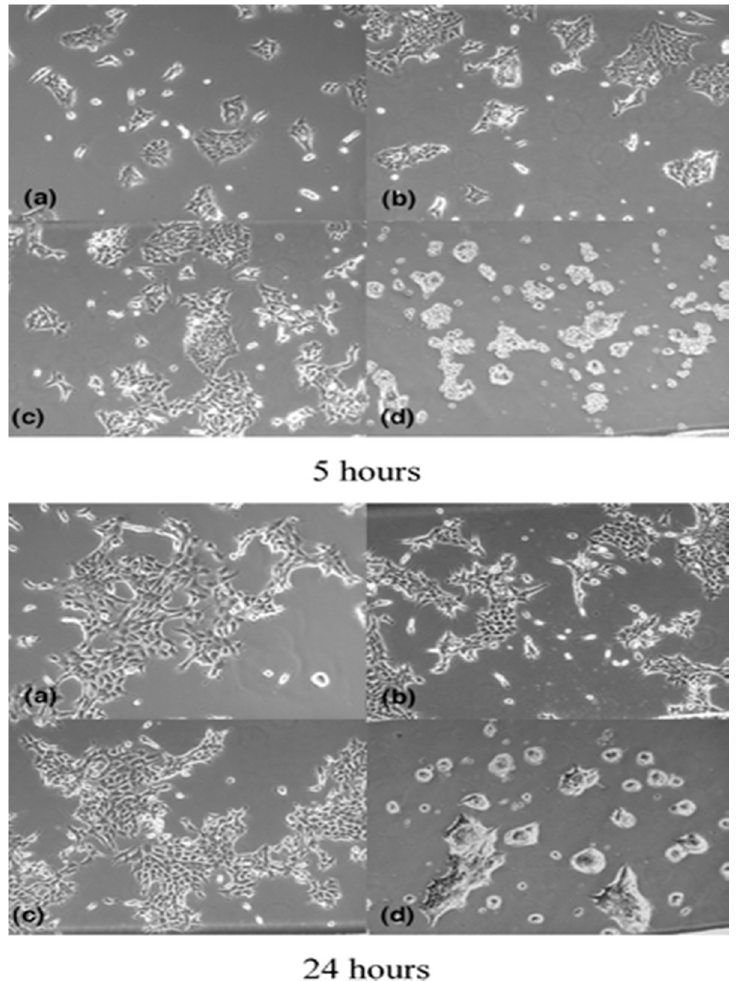
Figure 3. Phase-contrast images of NMuMG cells in various forms of cell culture. Panels ( a – c ) represent the NMuMG cells in standard forms of cell culture. Panel ( d ) represents the cells that were seeded in the developed gelation microfluidic device. Top and bottom subfigure sets are collected after 5 and 24 hours, respectively. Reprinted from [40] with permission. © 2006 Royal Society of Chemistry.